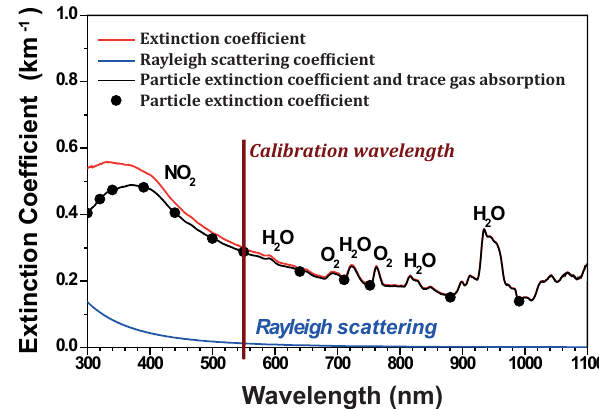
Fig. 4. SÆMS observation of spectral atmospheric extinction (red line), measured spectrum of the extinction coefficient after the cor- rection for Rayleigh scattering (black line), Rayleigh scattering con- tribution to the measured spectrum (blue line), and particle extinc- tion coefficient (black circles) after corrections for trace gas absorp- tion and Rayleigh